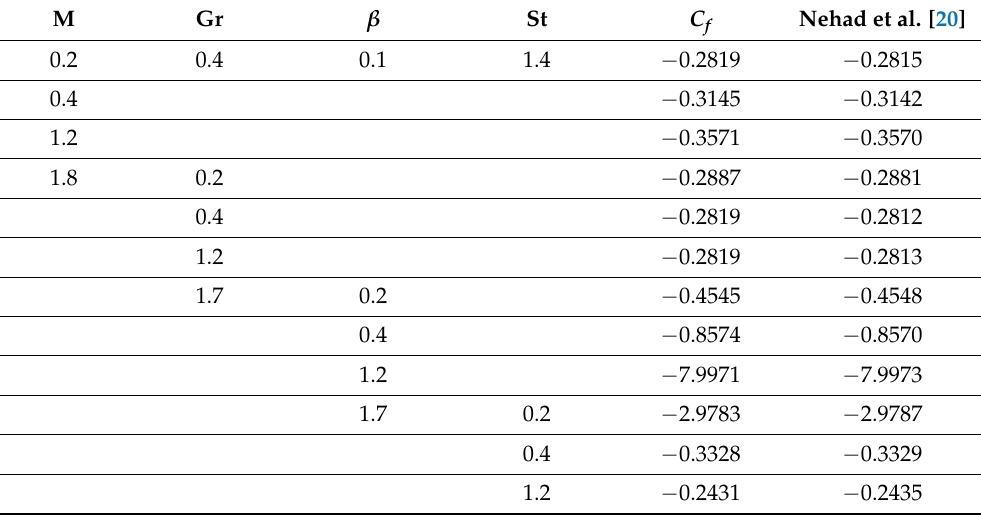
Table 2. Influence of M, Gr, b, and St on skin friction and its stability.